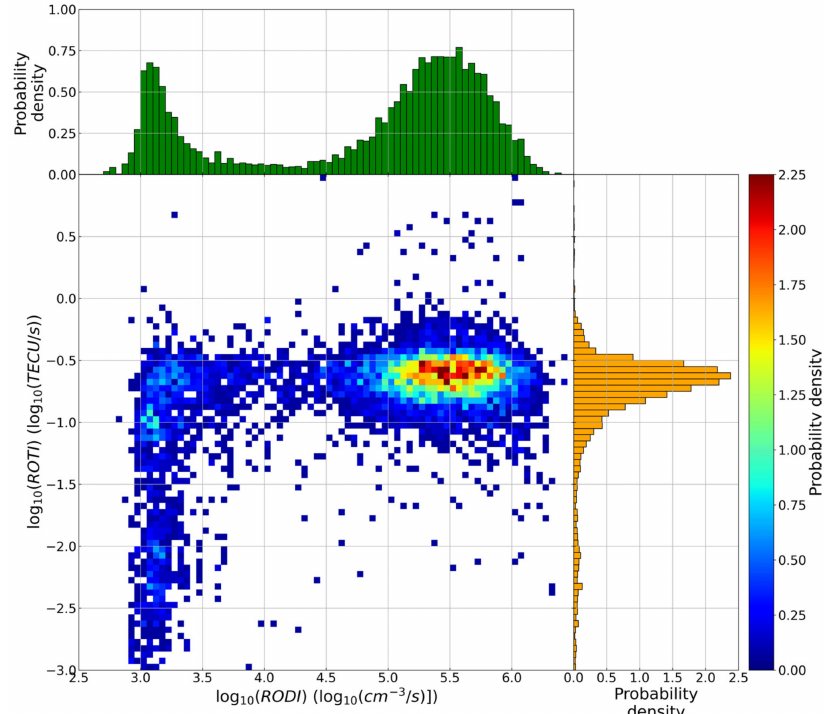
Figure 11. Same as Figure 9 but selecting only GPS LoL events occurred for |QD latitude| ≤ 45 ◦